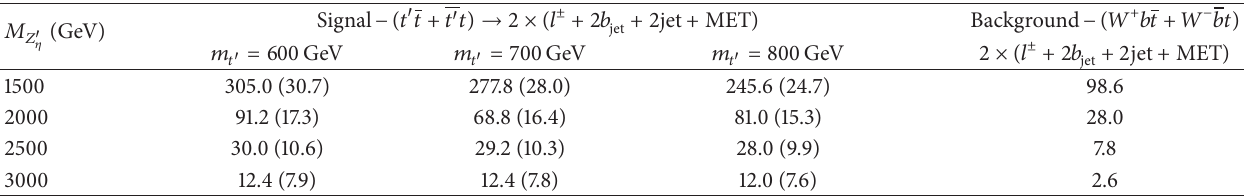
Table 12: The number of signal and background events for the final state 𝑙 ± +2𝑏 jet +2 jet + MET at the center of mass energy √𝑠 = 13 TeV and integrated luminosity 𝐿 int = 10 5 pb −1 . The numbers in the parentheses denote the signal significances (SS). These results are achieved for the 𝑥 = 0.1 . 𝑍 󸀠 𝜂 model and parameter